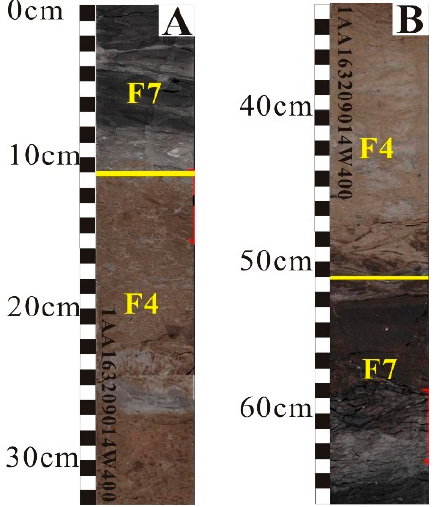
Figure 5. Succession of Facies 4 and 7. ( A ) Top segment of the succession (0–33 cm); ( B ) Bottom segment of the succession (33–66 cm).